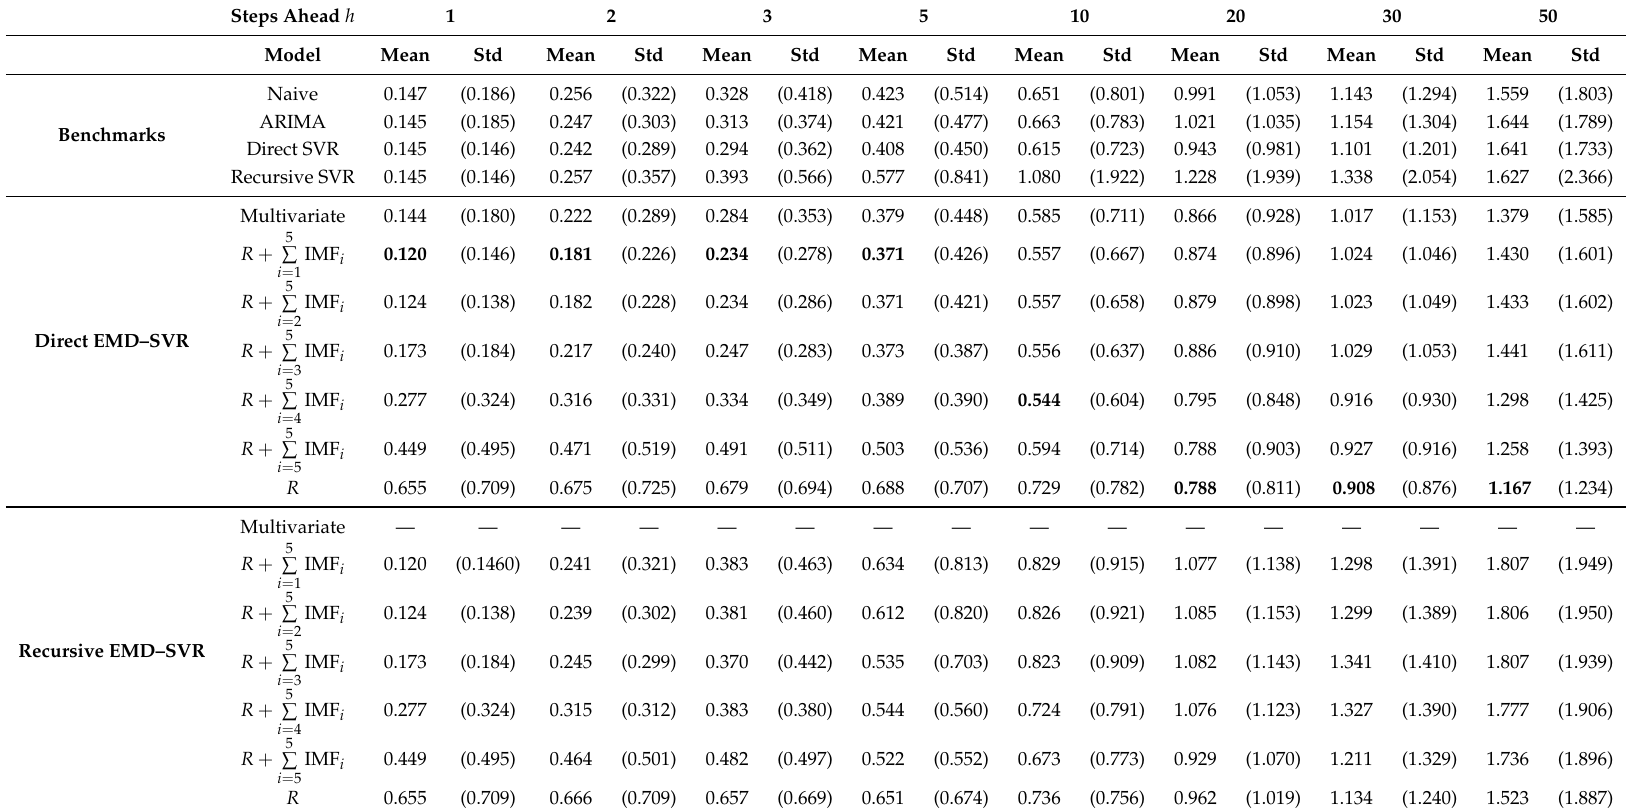
Table A2. Mean absolute error (MAE) and standard deviation (std) for the considered forecasting models: naive, autoregressive integrated moving average (ARIMA ( p , d , q ) ), univariate and multivariate empirical mode decomposition–support vector regression (EMD–SVR) with input vector m = 5 lagged values. The smallest MAE of each forecast horizon is set in